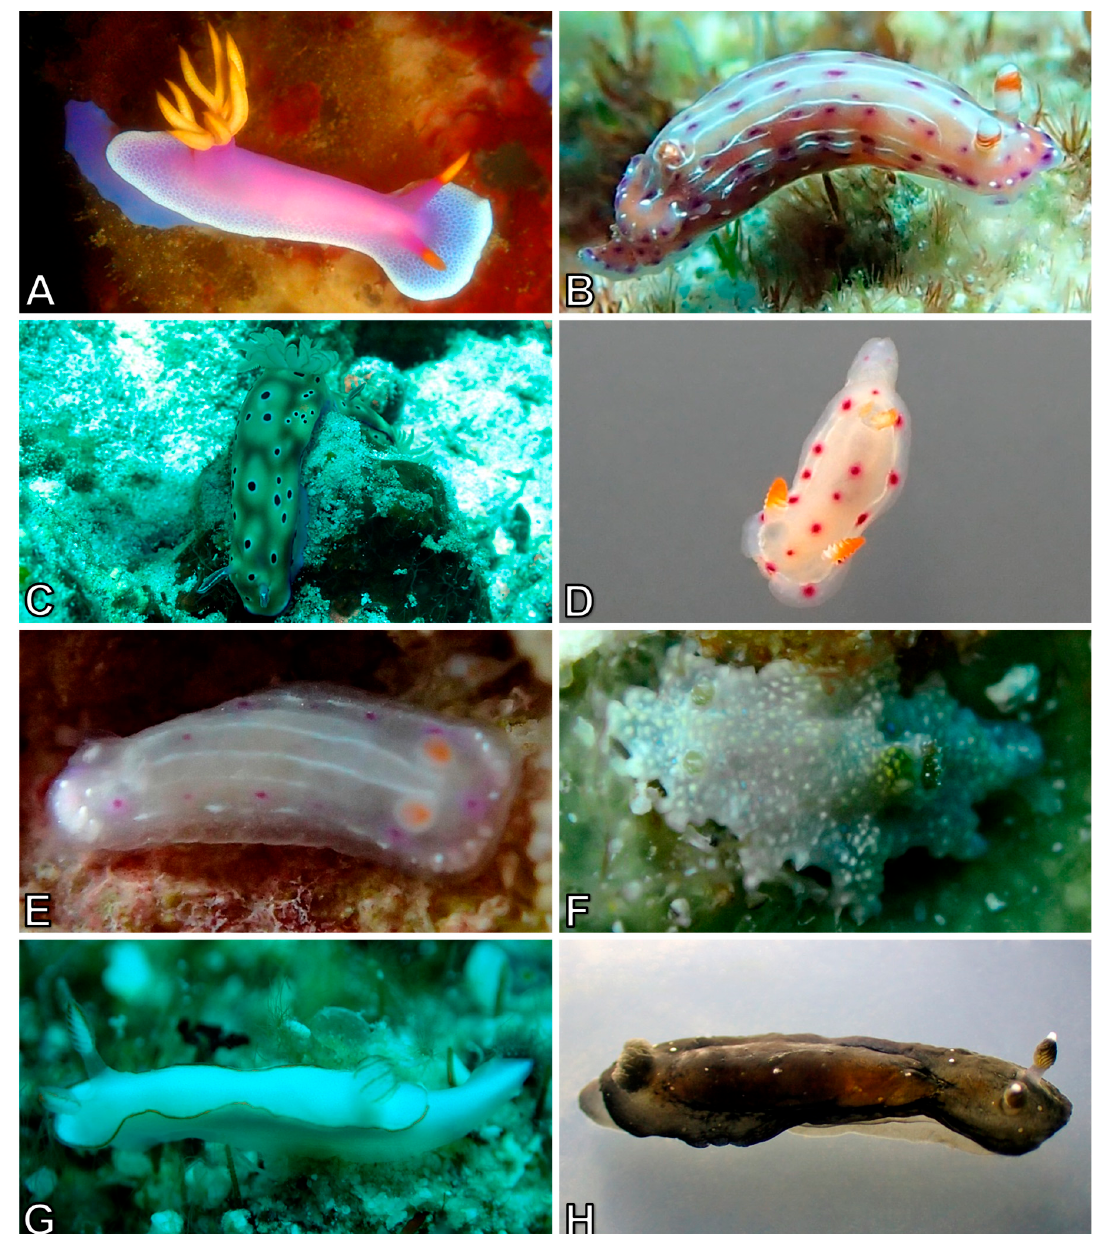
Figure 10. Nudibranchia - Doridina: ( A ) Hypselodoris apolegma; ( B ) Hypselodoris maculosa; ( C ) Hypselodoris tryoni; ( D ) Hypselodoris spec., Hysp16Bu-1; ( E ) Hypselodoris spec., Hysp2_16Bu-1; ( F ) Miamira sinuata ; ( G ) Thorunna furtiva; ( H ) Dendrodoris nigra .